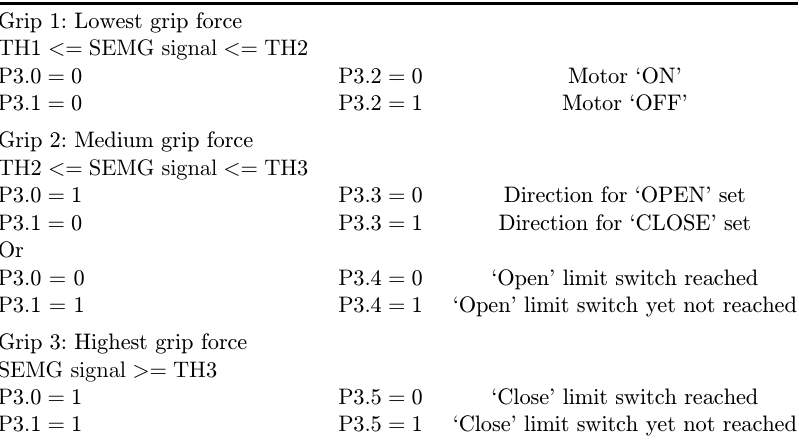
Table 1. Di®erent microcontroller port-bits function.